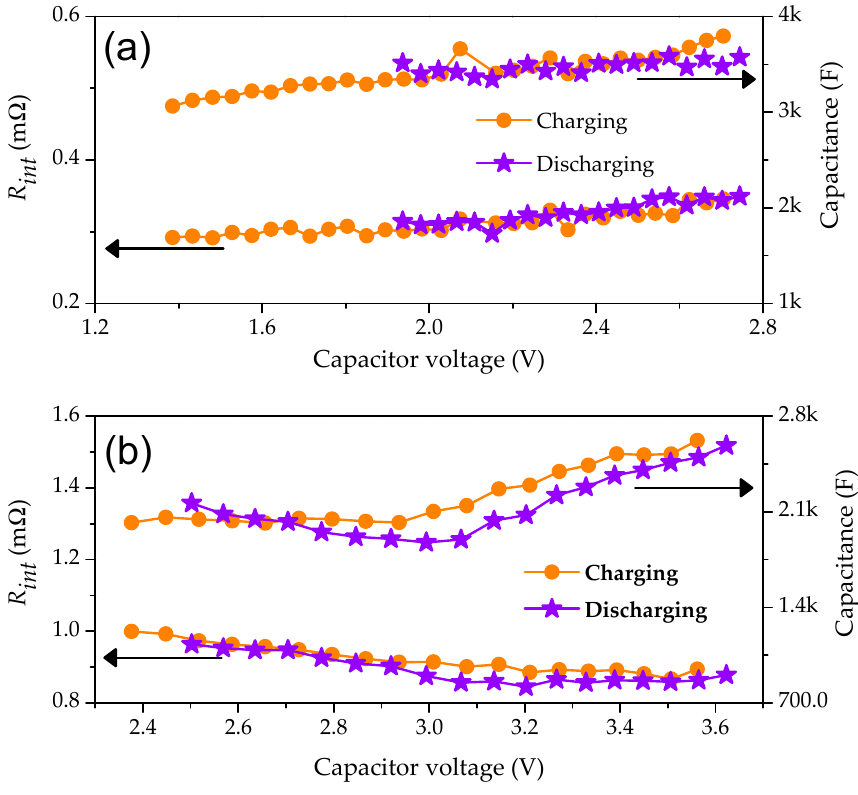
Figure 4. Internal resistance and capacitance for charge and discharge processes of ( a ) symmetric double-layer UC; ( b ) asymmetric Li-ion UC. Table 1. Average values of internal resistance ( R int ) and capacitance for both UCs during charge and discharge currents of 20, 50, and 75 A.